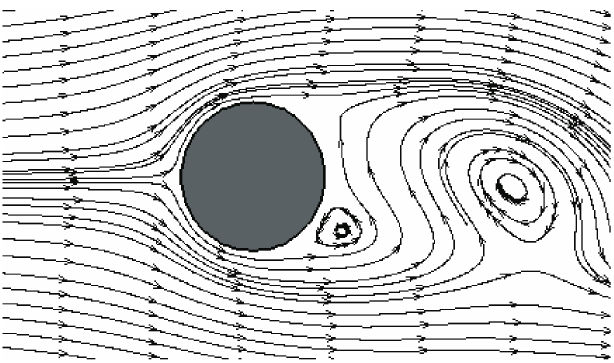
Figure 1. Fluid flow passing a circular cylinder without passive control.